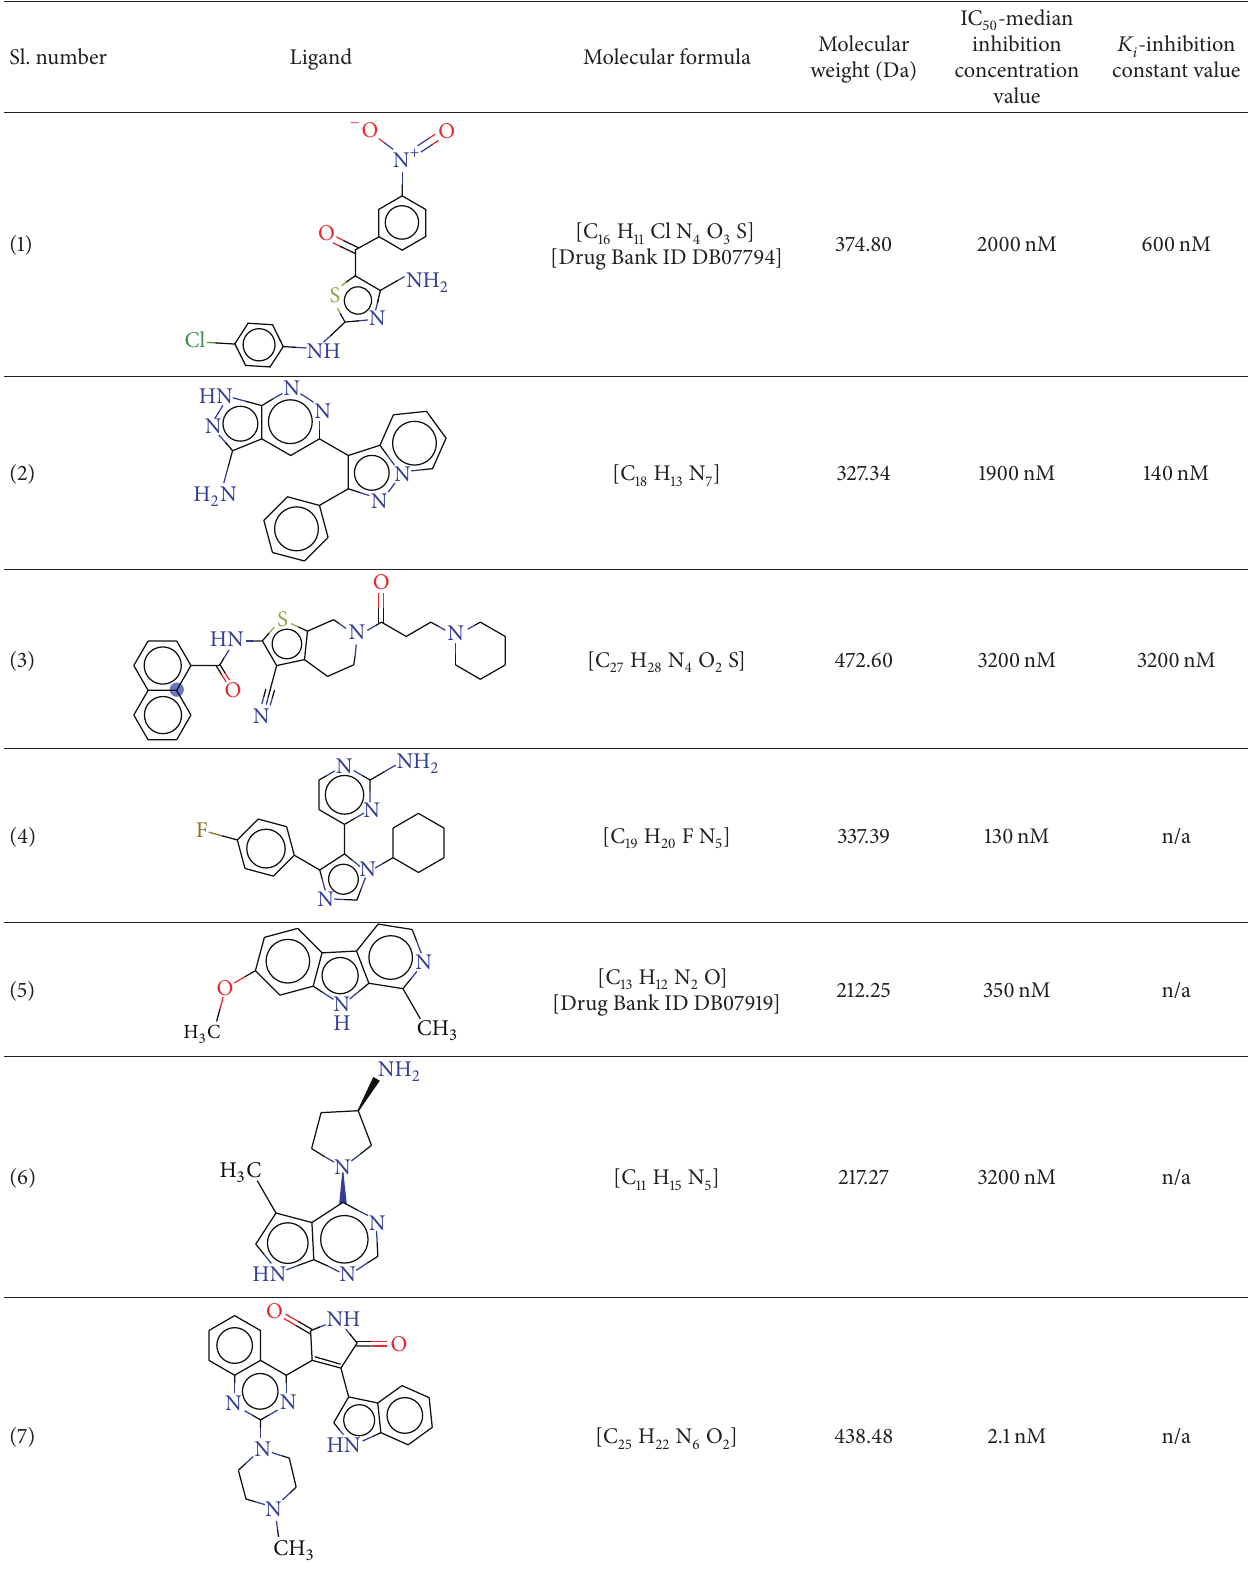
and 𝐾 𝑖 ) values. 50